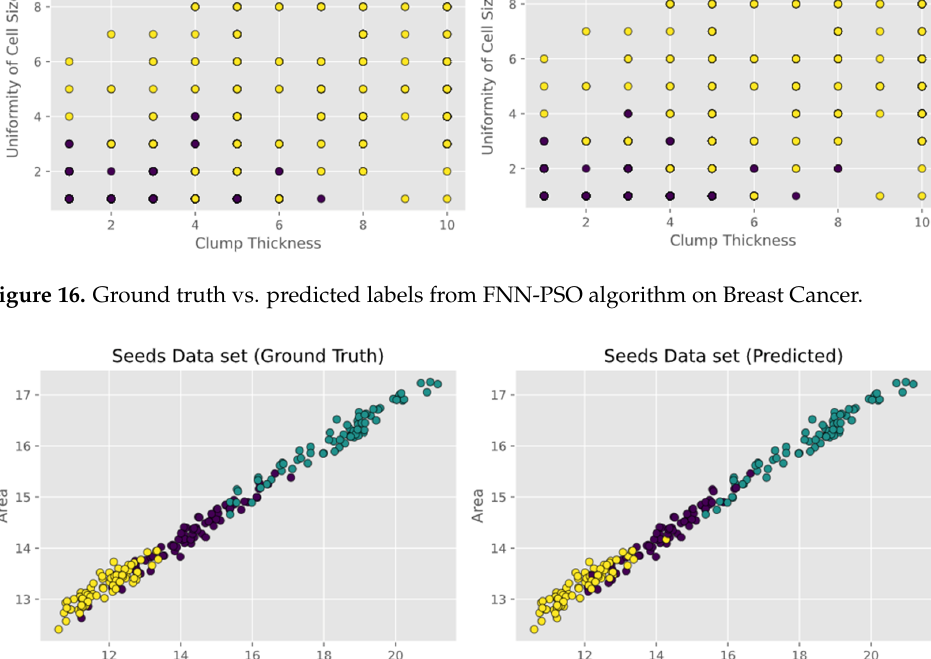
Mach. Learn. Knowl. Extr. 2021 , 3 FOR PEER REVIEW Figure 17. Ground truth vs. predicted labels from FNN-PSO algorithm on Seeds Figure 17. Ground truth vs. predicted labels from FNN-PSO algorithm on Seeds Figure 17. Ground truth vs. predicted labels from FNN-PSO algorithm on Seeds. Figure 17. Ground truth vs. predicted labels from FNN-PSO algorithm on Seeds